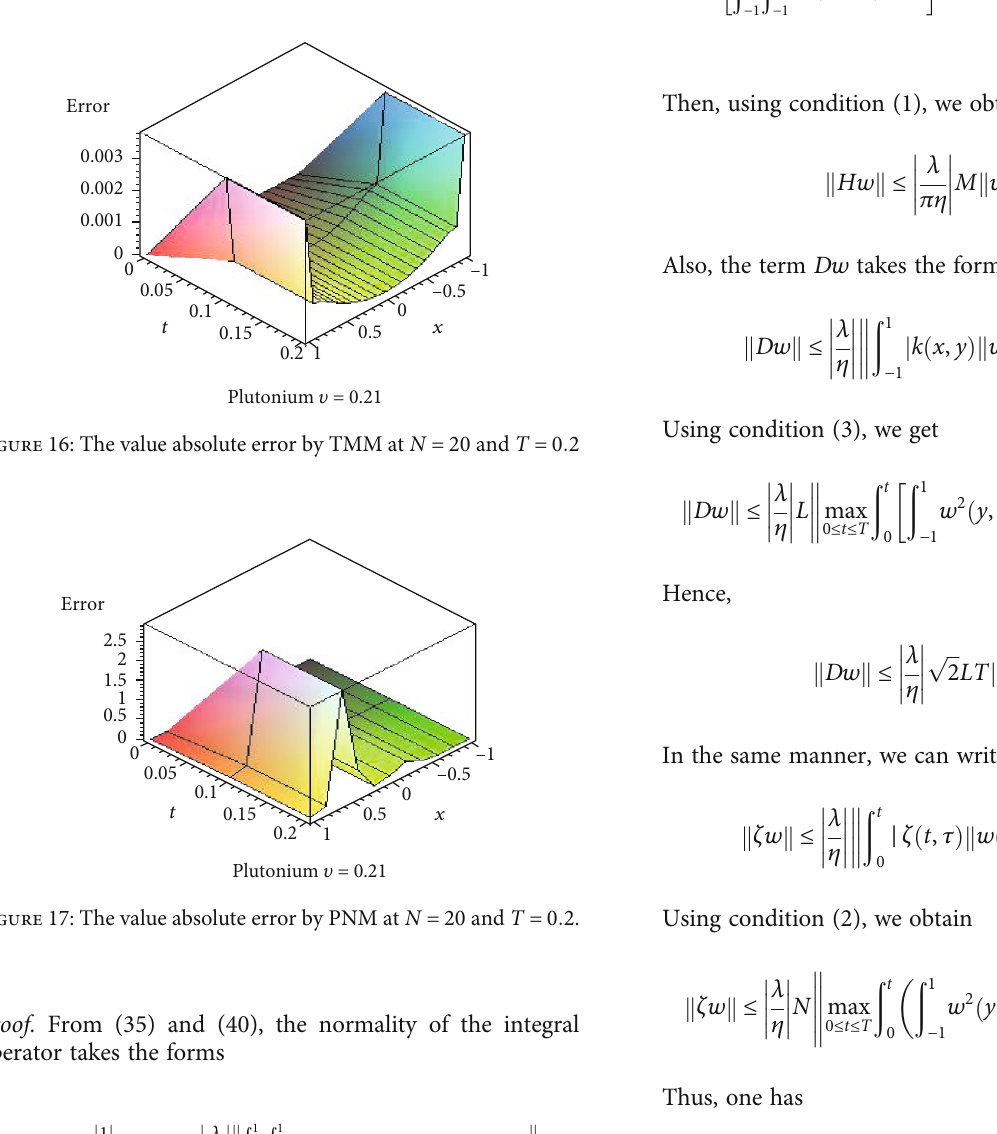
Figure 15: The value absolute error by PNM at N = 10 and T = 0 : 2 .